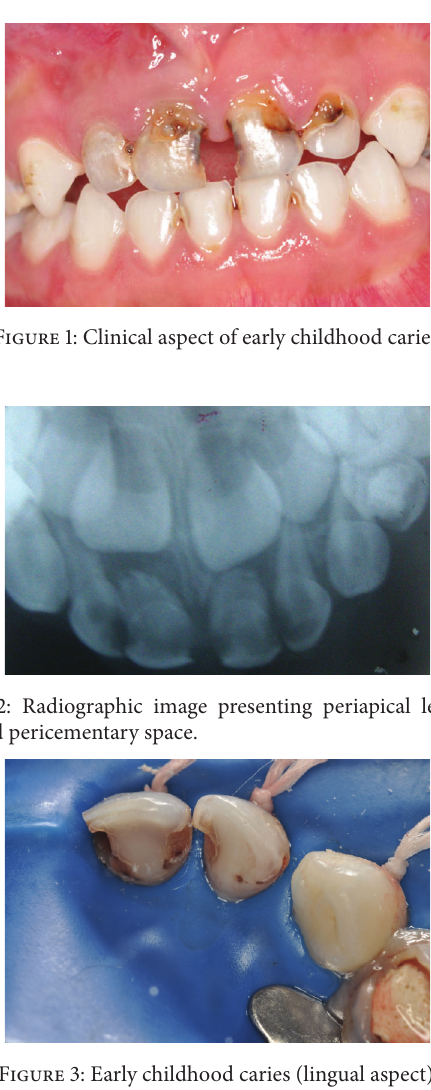
Figure 3: Early childhood caries (lingual